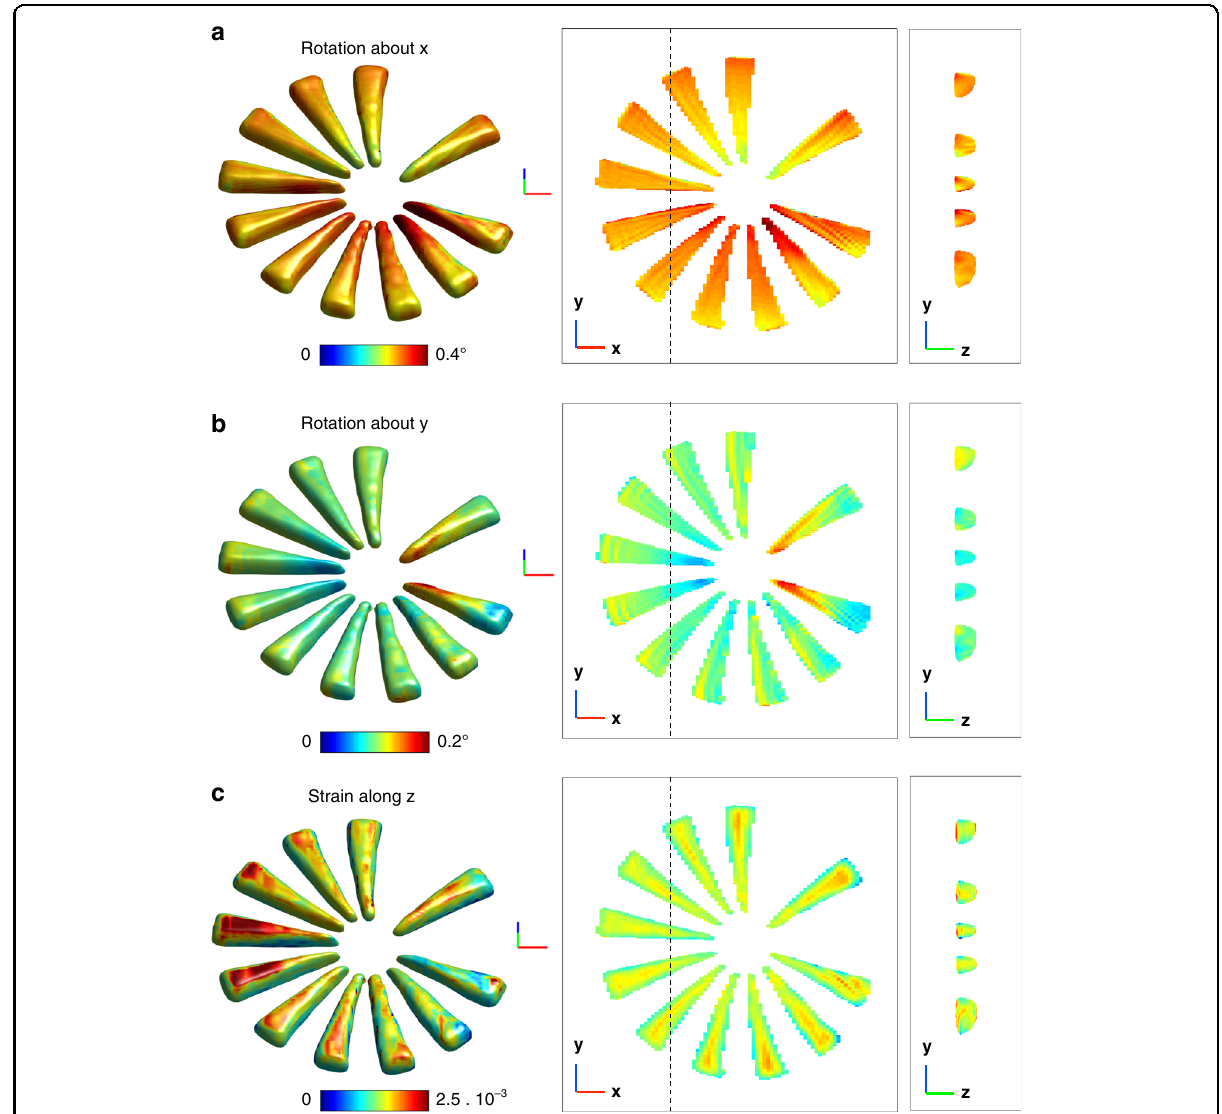
Fig. 3 3D crystalline properties extracted from the retrieved phase map. a , b Rotation of the 220 lattice planes, about the x and y axes, respectively. The rotation color map angle is shown in degree. c Strain of the 220 lattice planes. The strain color map is shown in arbitrary units. In a – c , the left column corresponds to a 3D rendering of the map onto the volume de fi ned in Fig. 2a while the middle and right columns are de fi ned as in Fig. 2b, c, respectively. The length of each segment of the 3D frame represents 200